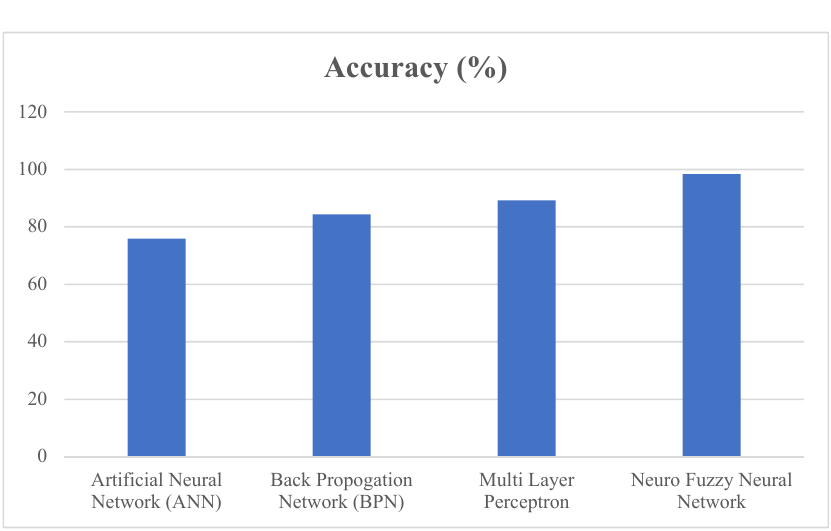
Figure 11. EER calculation for different classifiers.